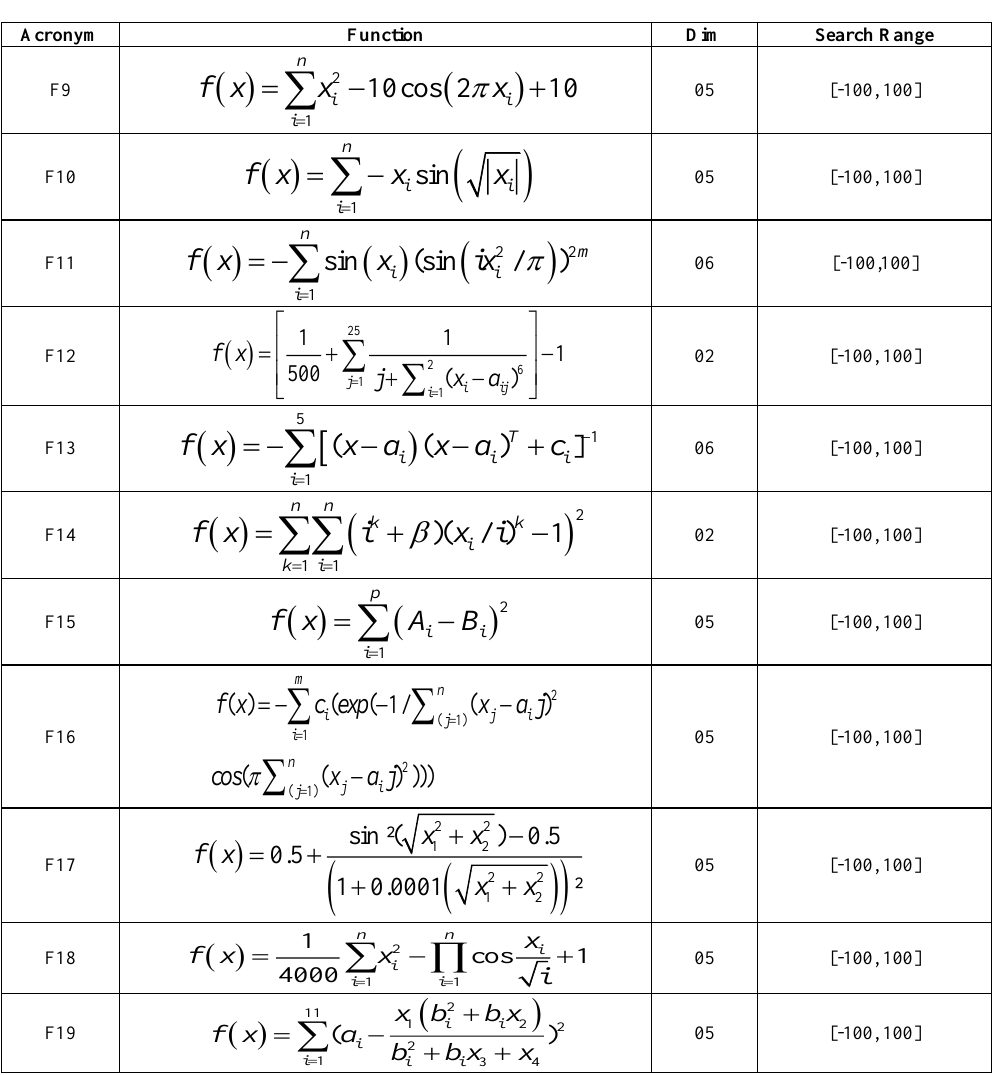
Table 2. Multimodal benchmark